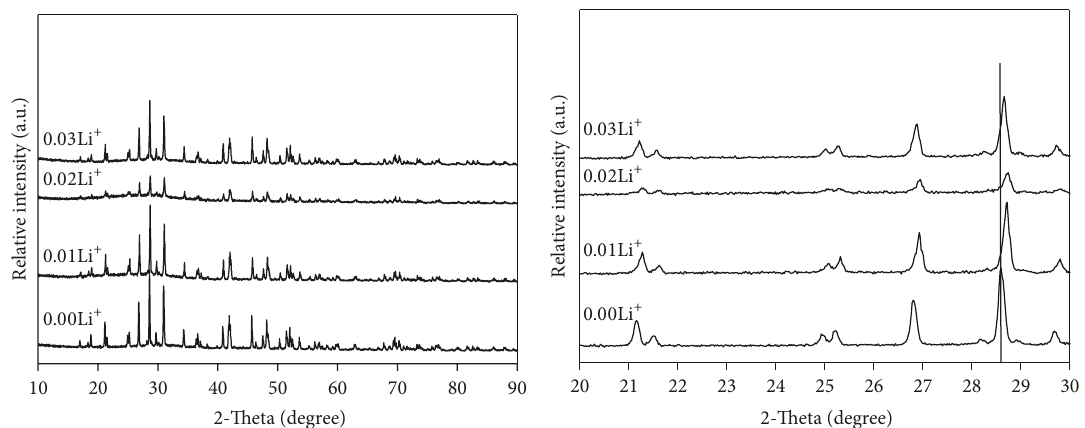
Figure 1: XRD patterns of La 0.97 PO 4 :Bi 3+ 0.03 , Li + x (x = 0.00, 0.01,0.02,0.03 ) samples calcined at 1200 ∘ C for 8 h. - x